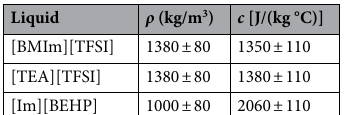
Table 2. Density and specific heat capacity of ILs.